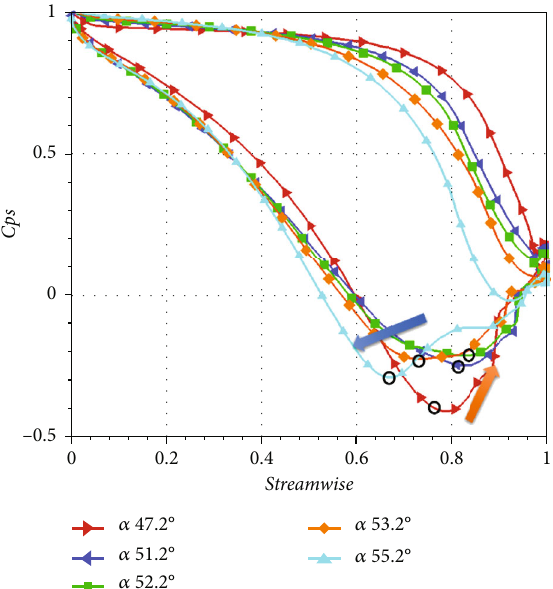
Figure 7: Comparison of static pressure coe ffi cient near the midspan of the blade for di ff erent stagger